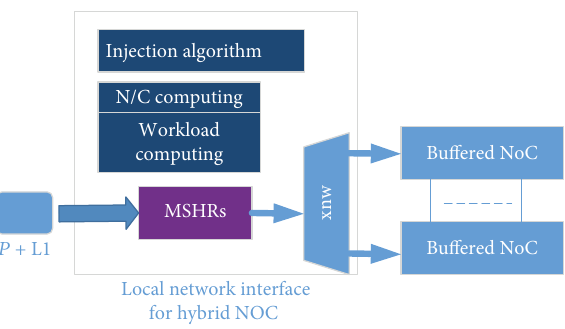
Figure 5: Network interface of the hybrid